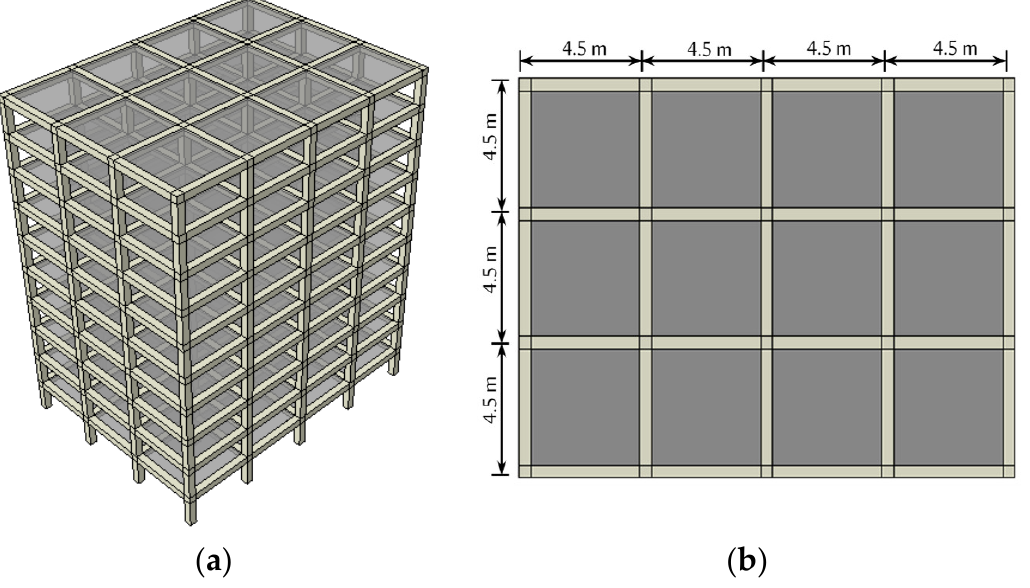
Figure 2. Typical plan and 3D view of the building considered in this study: ( a ) three-dimensional view; ( b ) floor plan.